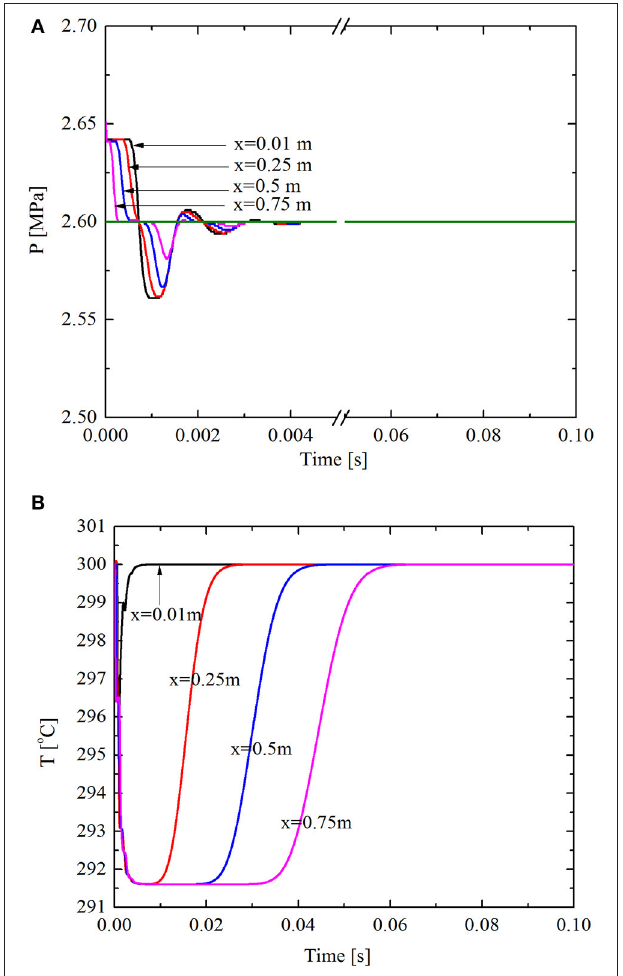
FIGURE 3 | Responses of the nearly-implicit method under outlet pressure transient. (A) Pressure responses. (B) Temperature responses.